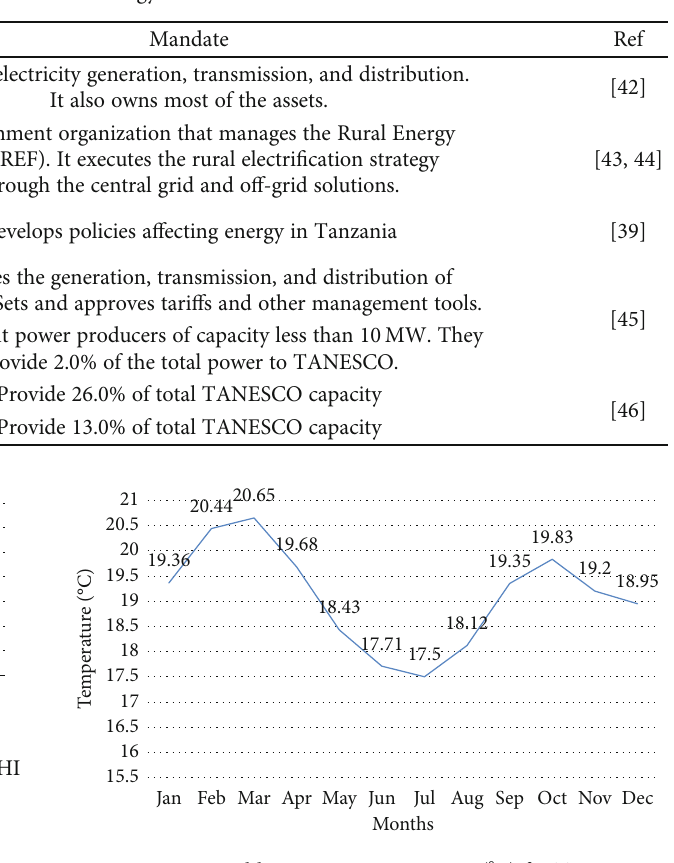
Figure 27: Monthly temperature variation ( ° C) for